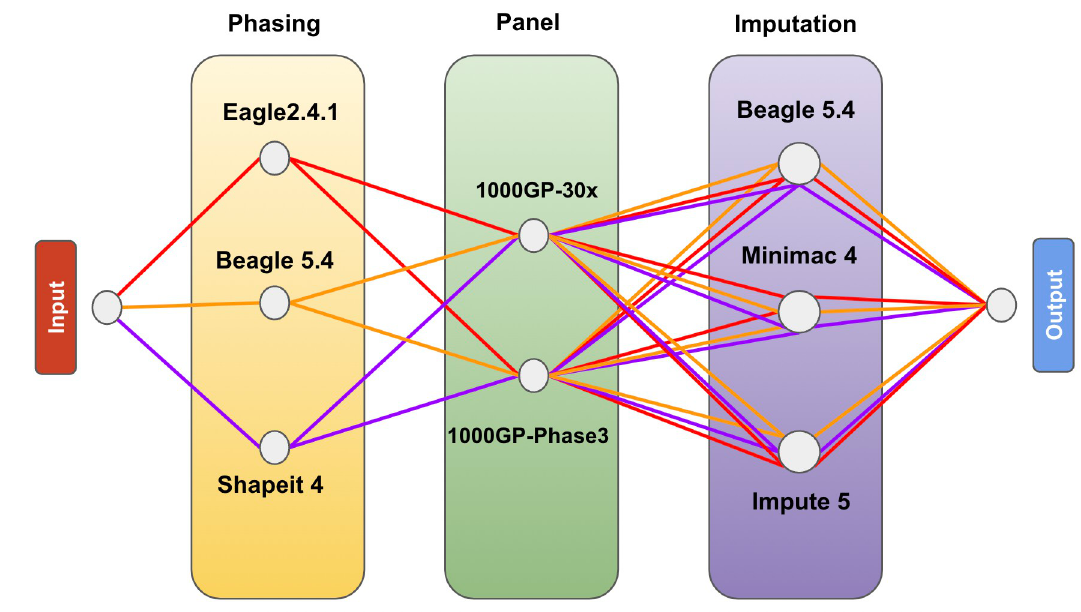
Fig 2. Workflow of the analysis, combinations tested. Affymetrix, Omni, Customized, and EBB input chip datasets were analyzed using the 36 combinations of 3 different phasing software, 2 phasing approaches, 3 imputation software, and 2 imputation reference panels. EBB input chip dataset was analyzed using the 36 combinations of 3 different phasing software, 2 Reference panels, 2 phasing approaches and 3 imputation software.